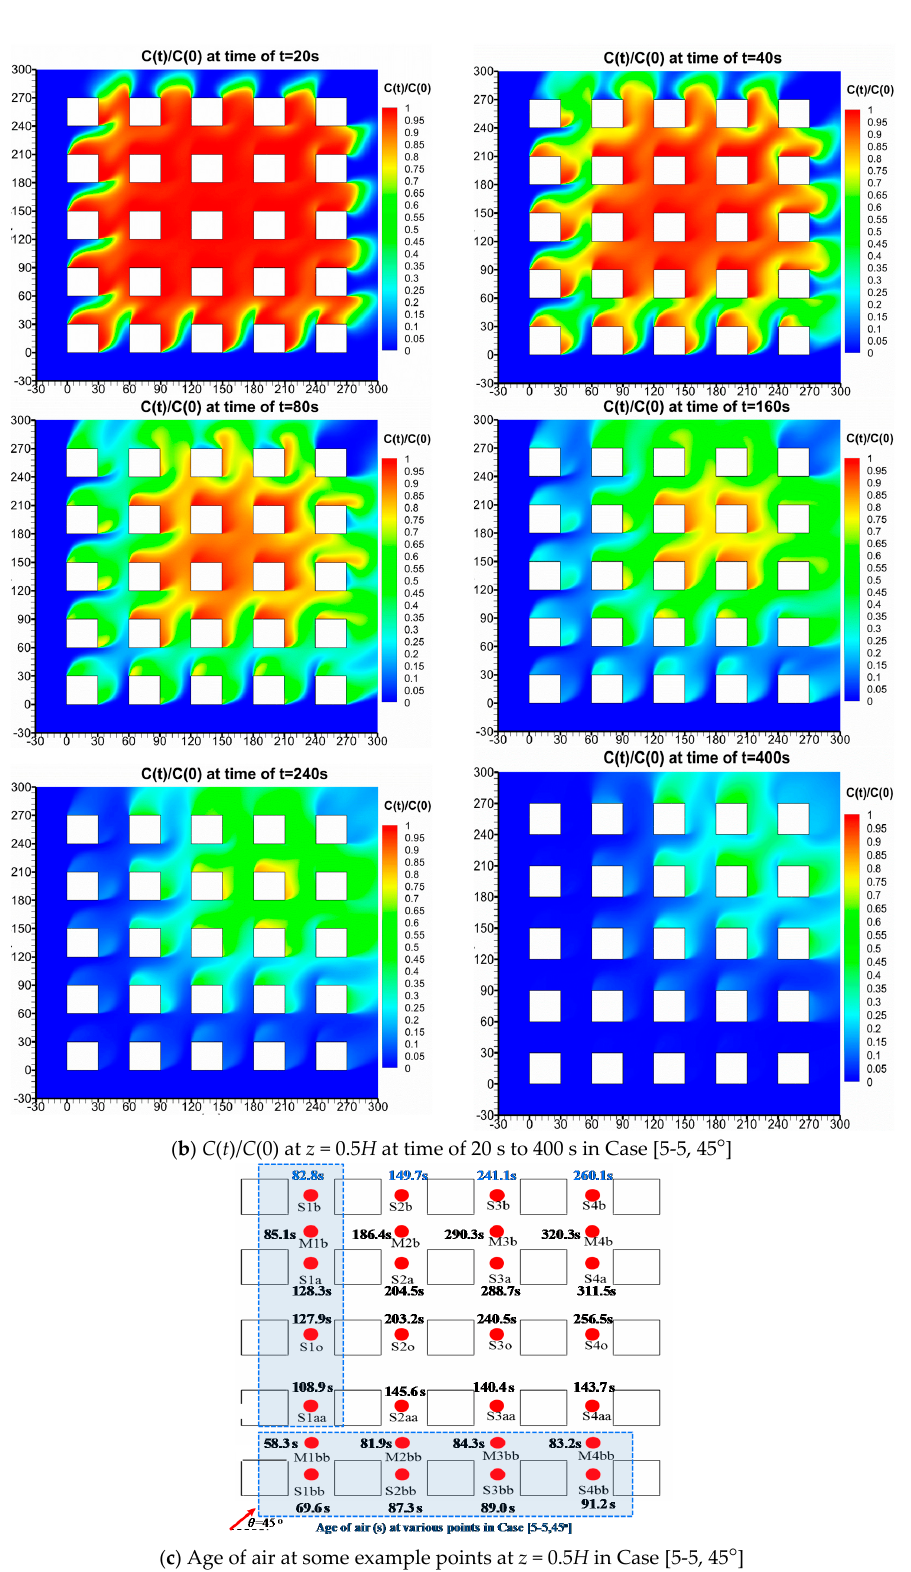
Figure 6. In Case [5-5, 45 ° ]: ( a ) 3D streamline and the normal velocity in z = 0.5 H ; ( b ) C ( t )/ C (0) in z = 0.5 H at time of 20 s to 400 s; ( c ) age of air at some example points at z = 0.5 H .